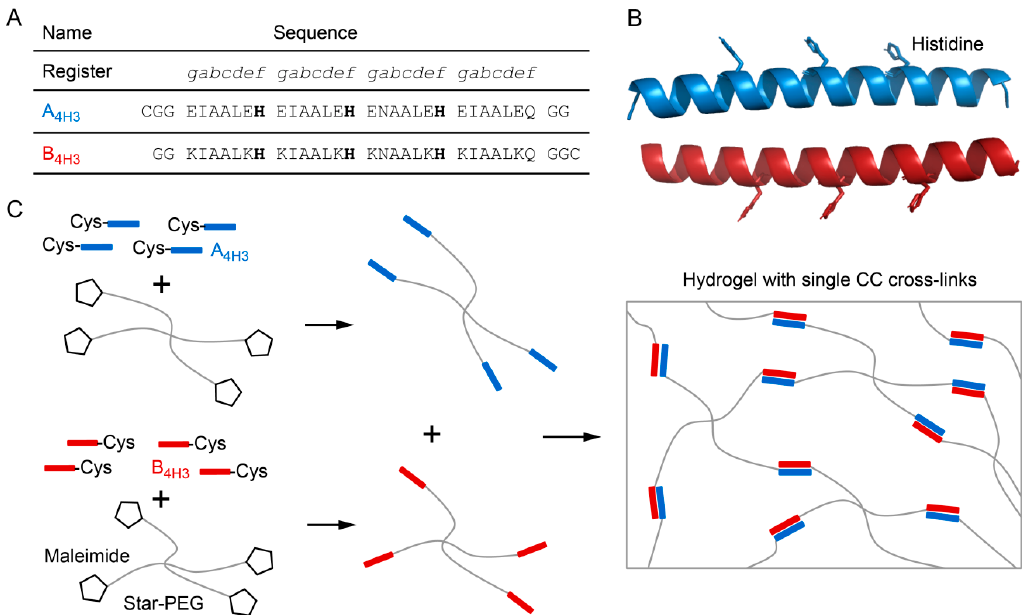
Figure 1. Metal coordinating coiled coil (CC) cross-linked hydrogel. ( A ) Sequences of the acidic (A 4H3 ) and basic (B 4H3 ) CC-forming peptides, carrying three histidines (bold) in the solvent-exposed f positions. Cysteine residues were added at the N-terminus of A 4H3 and the C-terminus of B 4H3 to facilitate coupling to maleimide-functionalized star-shaped poly(ethylene glycol) (star-PEG–maleimide). ( B ) Structure of the CC constructed in CCBuilder 2.0 [29]. The side chains of the histidine residues are highlighted. ( C ) Schematic representation of the hydrogel preparation and structure. A 4H3 and B 4H3 are separately coupled to star-PEG–maleimide via their terminal cysteine residues. The resulting PEG–peptide conjugates are then mixed in a 1:1 ratio to obtain a CC cross-linked hydrogel.